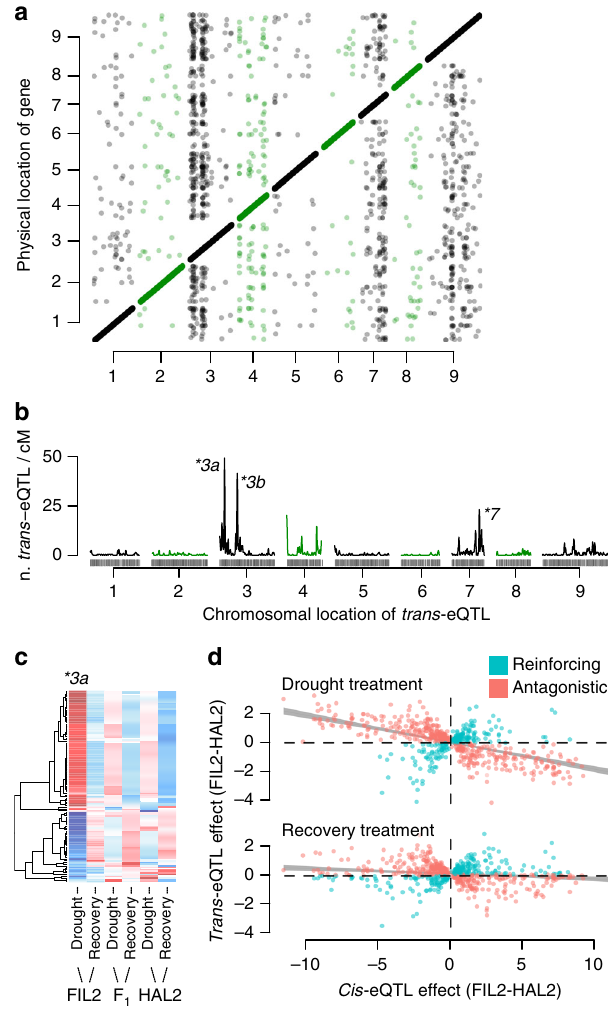
Fig. 3 Distribution and effect of trans-eQTL. The position of each cis (on diagonal) and trans-eQTL (off diagonal) and the location of the proximate marker to the physical gene position are plotted ( a ). Points and line segments are colored green/black to distinguish adjacent chromosomes. The density of trans-eQTL/cM along sliding windows were scored across the genome ( b ). The three strongest peaks (hotspots) are labeled (*). The allelic effects of the *3a trans-eQTL are plotted as heatmaps, where red colors indicate higher gene-scaled expression ( c ). The color scale of the heatmap corresponds to the scaled allelic effects of the *3a hotspot, where increasing blue and red color intensity indicate stronger negative and positive allelic effects respectively. White cells have a scaled allelic effect of zero. We tested for biases of compensatory or reinforcing evolution between cis and trans eQTL. Overall, there was signi fi cant biases towards antagonistic effects, however this bias was much stronger in the drought than recovery treatment ( d ). Source data for panels a and d are found in Supplementary Table 8. Source data for panels b , c are provided as a Source Data fi